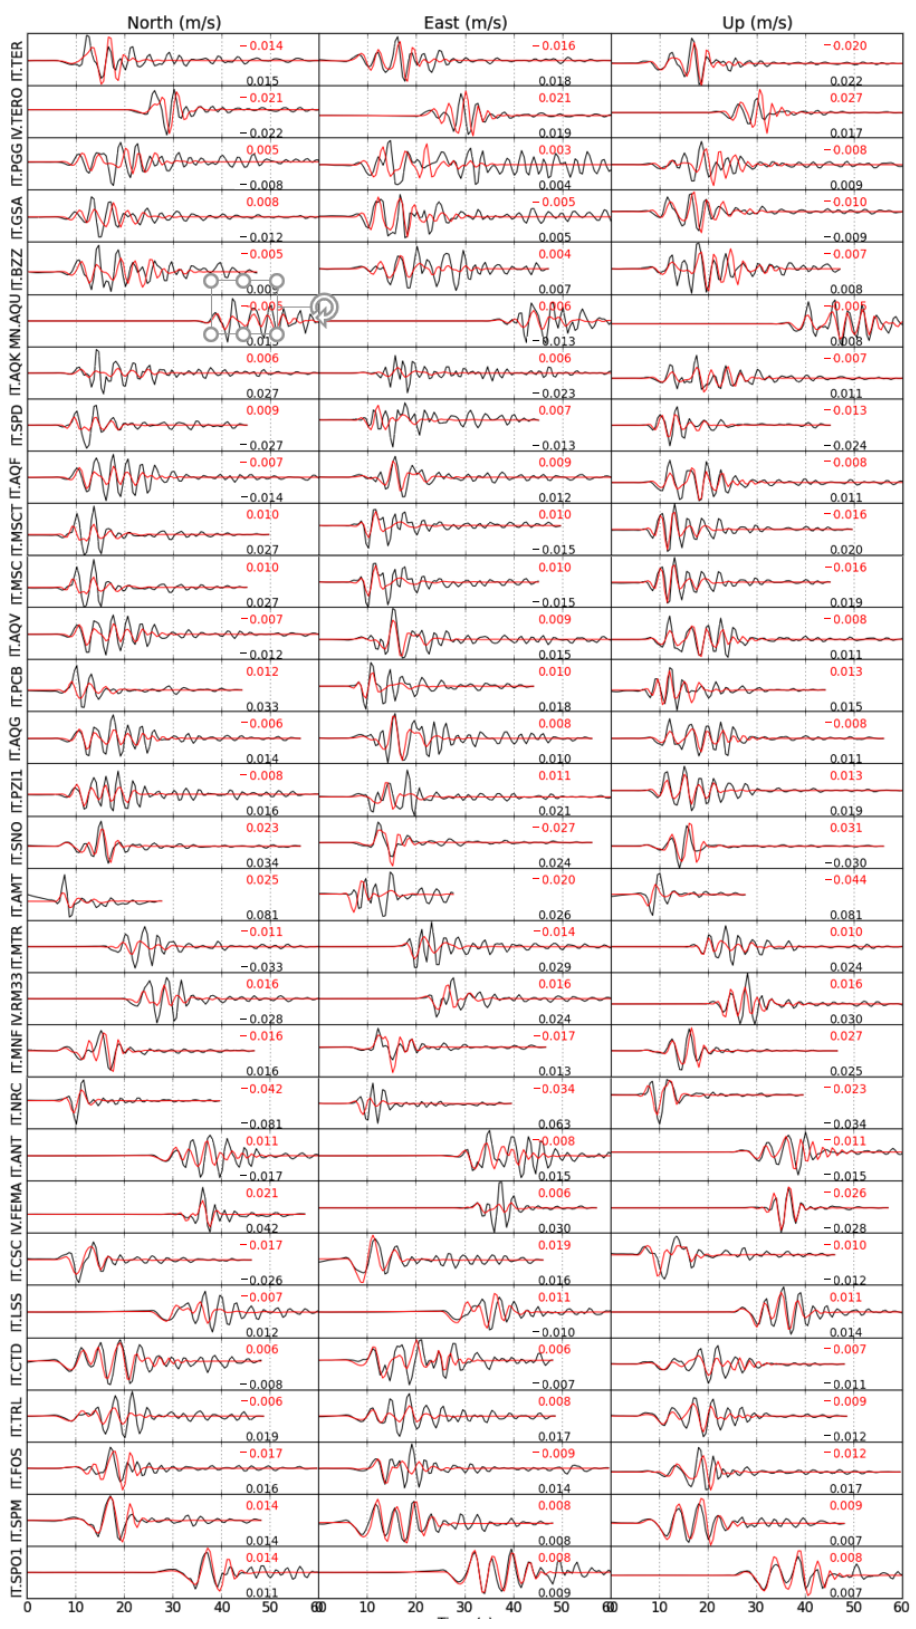
Figure A7. Comparison of strong-motion velocity records (black) and the synthetic seismograms (red) predicted by the joint slip model of the Amatrice earthquake.